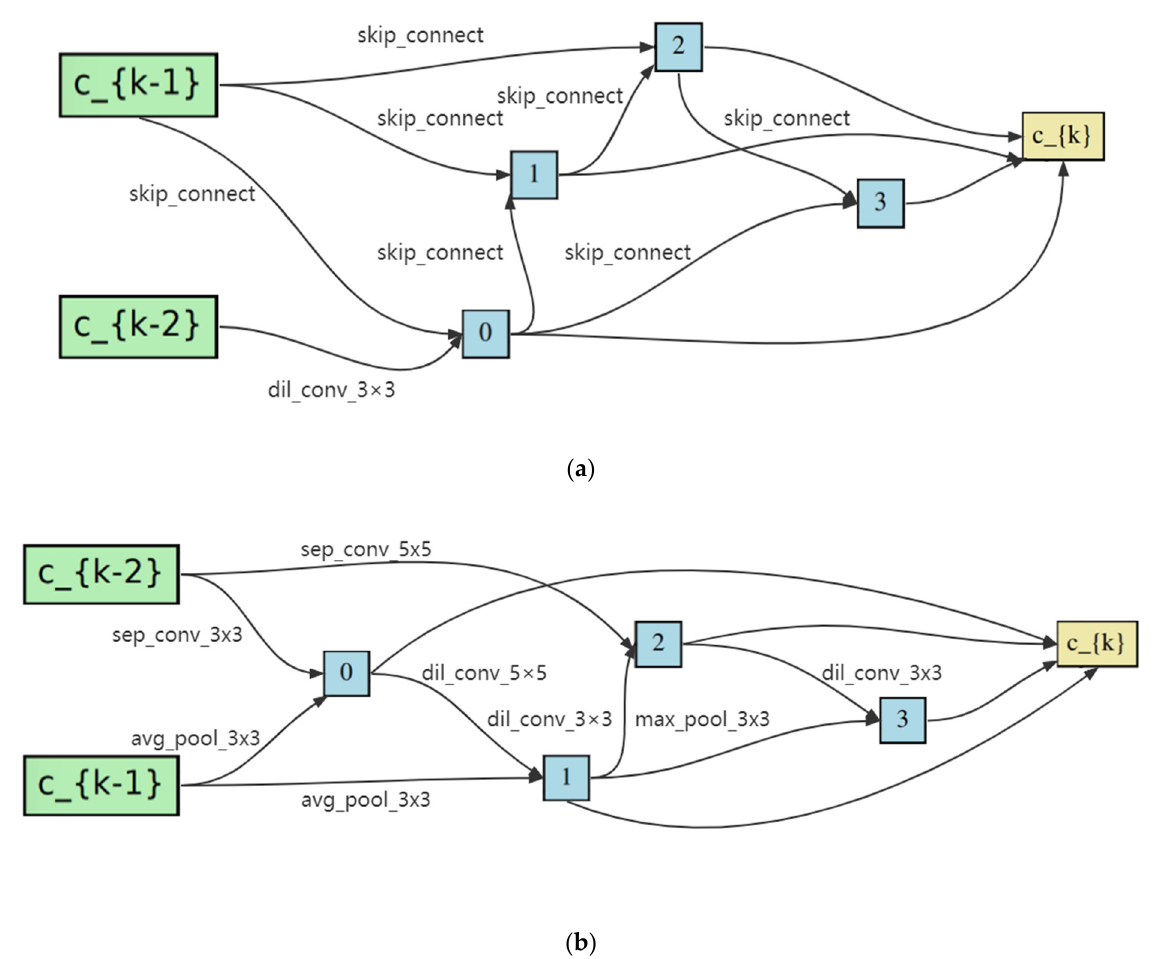
Figure 6. Searched cell architectures of Auto-RSISC [42]. ( a ) Normal cell searched by Auto-RSISC. ( b ) Reduction cell searched by Auto-RSISC.